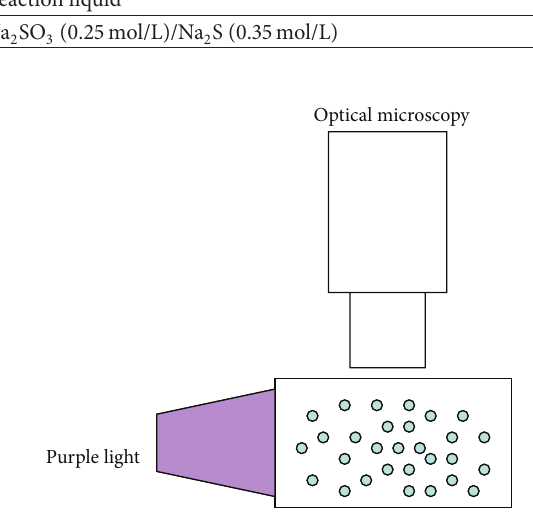
Figure 1: Reaction and measurement system.